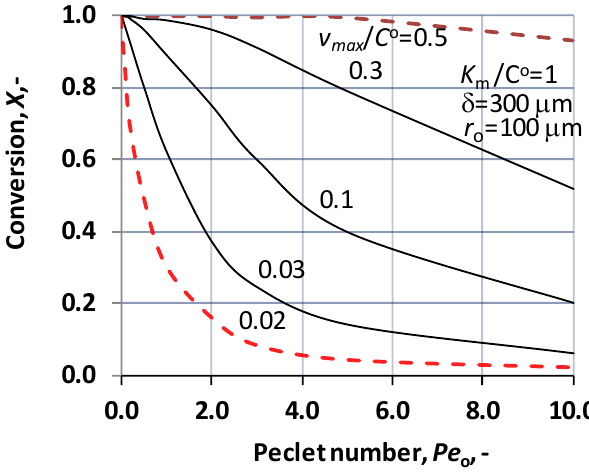
Figure 5. Change of conversion as a function of the inlet Pe o -number, at different values of v max /C O , under operating mode without sweeping phase, i.e., d C /d R = 0 at R = R m , applying the Michaelis–Menten kinetics ( N = 1000; δ = 300 μm r o = 100 μm; K M /C O = 1; D = 1.9 × 10 −9 m 2 /s).